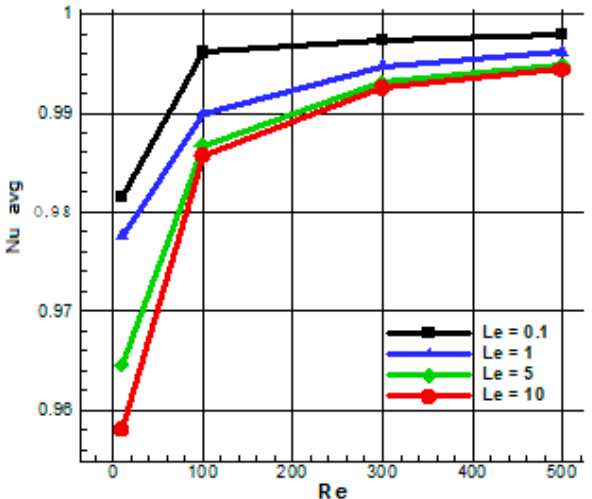
Figure 13. Average Nusselt number as a function of Re number for different Le number and Pr = 6.2, Le = 1, N B = N T = 0.1.